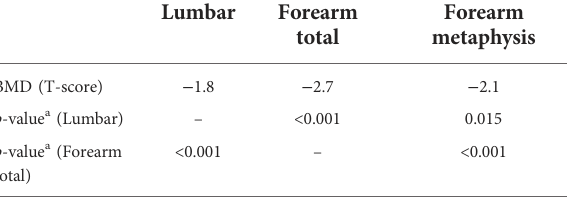
TABLE 2 Comparison between forearm BMD and lumbar BMD.